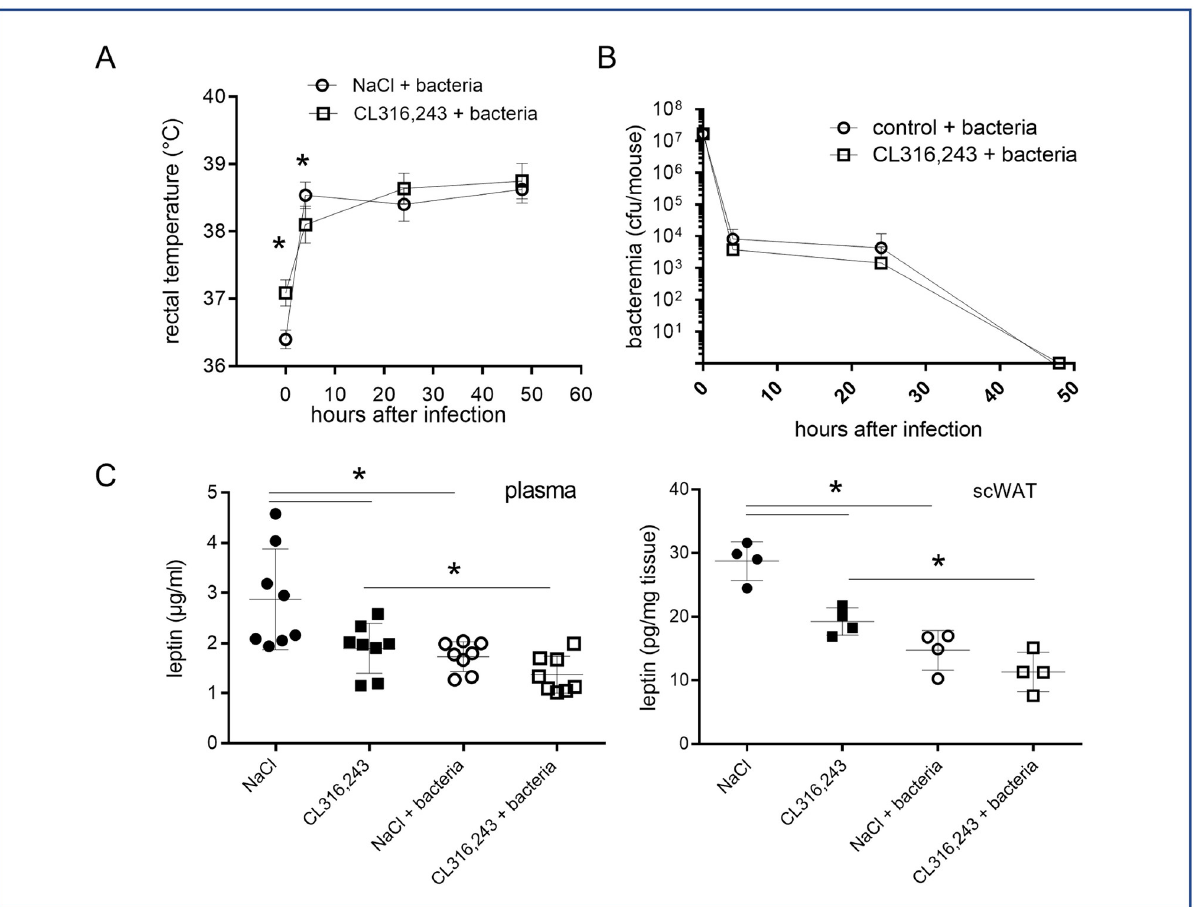
Fig 3. Pyrexia, bacteremia and leptin secretion in response to infection. (A) Rectal temperature and (B) bacteremia of mice treated or not with CL316,243 (1 mg/kg/day; 1 week) were monitored for 48 hours after infection by E . coli . (C) Mice plasma and scWAT explant leptin levels at the end of experiment. The results are displayed as independent values (dots) and the mean ± SD. n = 8 (mice and plasma) or 4 (scWAT explants). � p < 0.05.